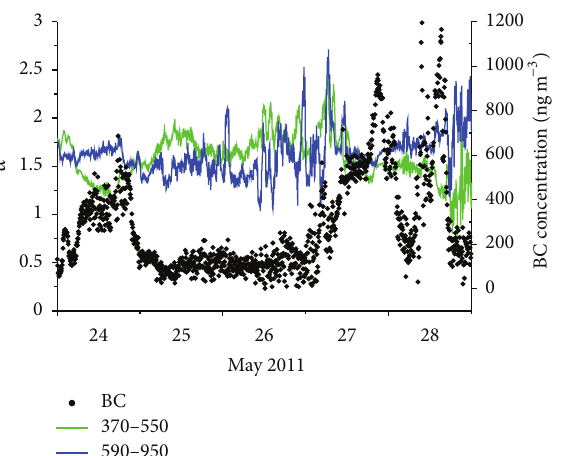
Figure 5: Time series of the hourly mean Angstr¨om exponent of the absorption coefficient on May 24–28, 2011.